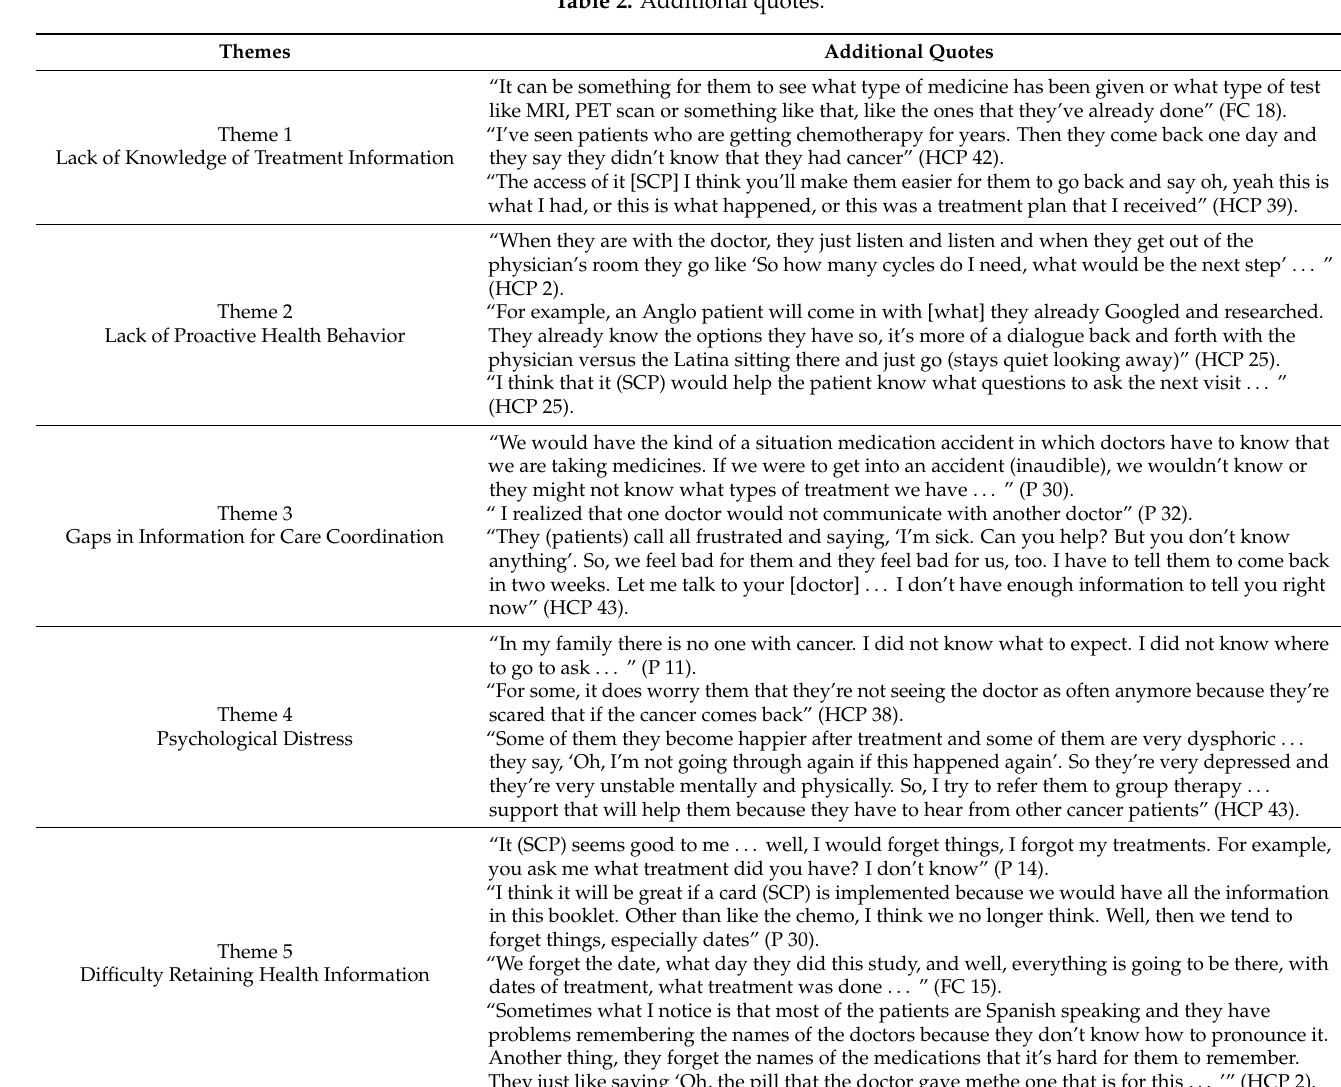
Table 2. Additional